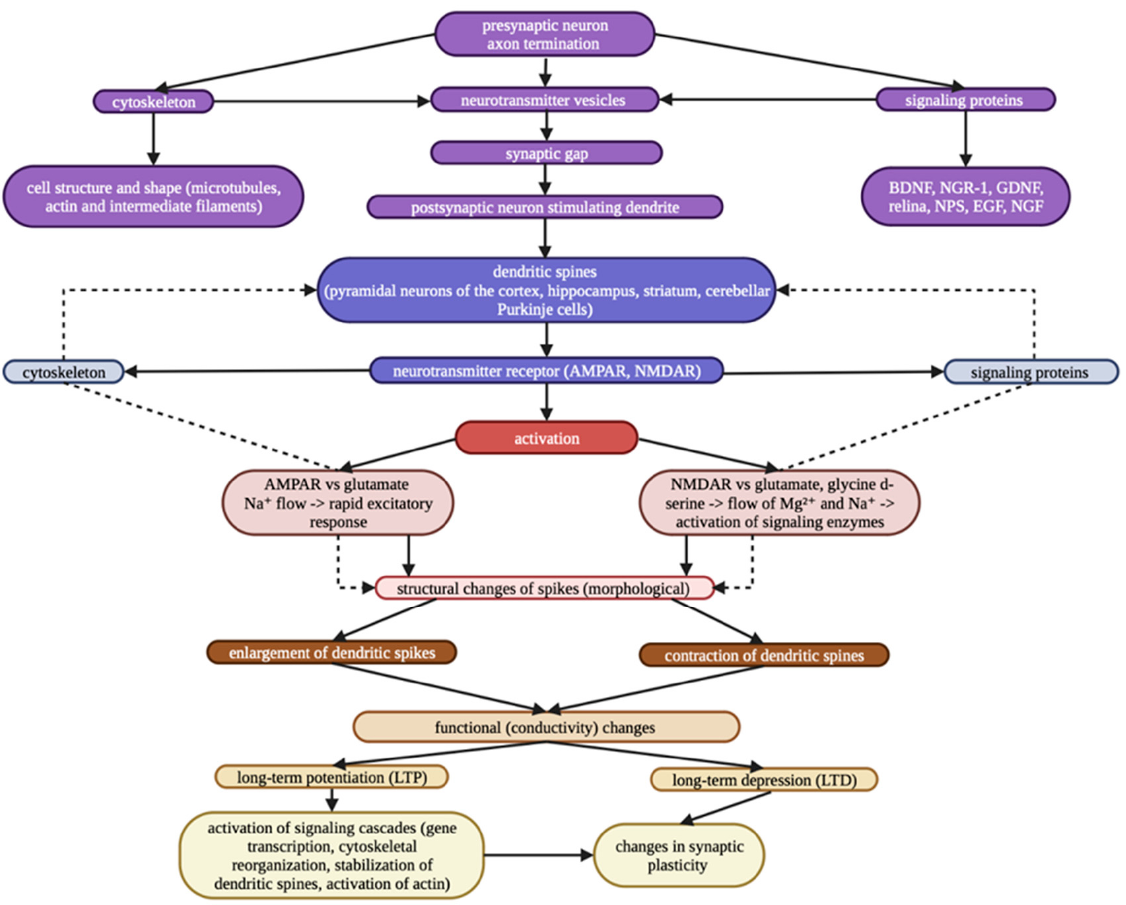
Figure 1. Neuroplasticity network.